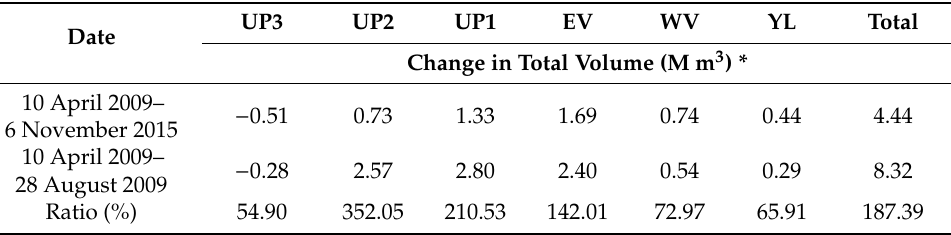
Table 5. Topographic change in the river